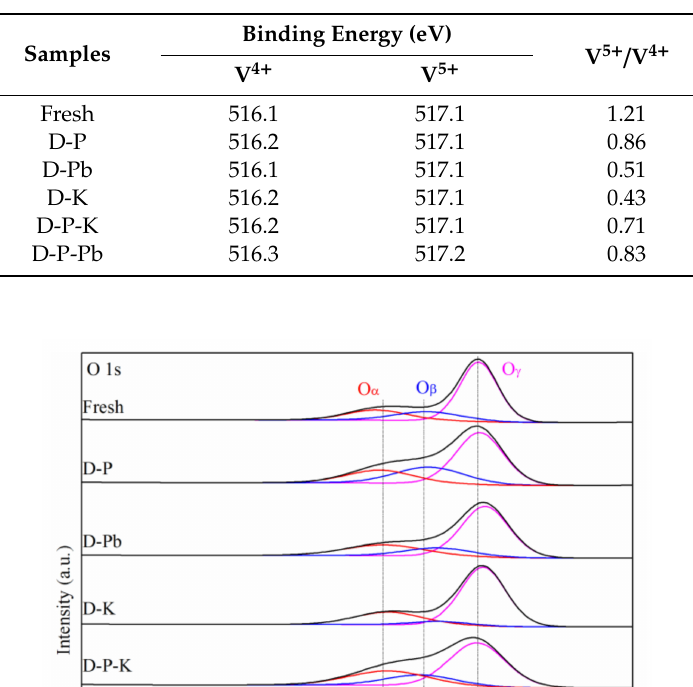
Table 3. XPS results of V 2p 3 / 2 and surface atomic ratio of V 5 + / V 4 + for each